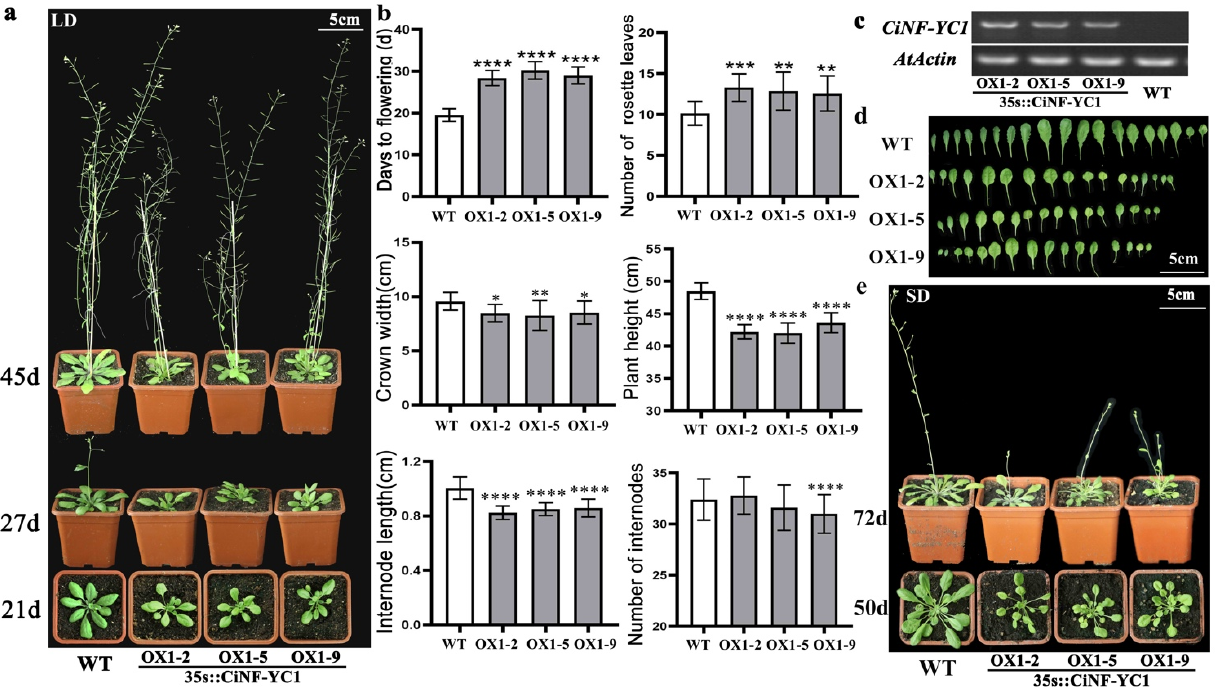
Figure 4. Flowering time and phenotype analysis of CiNF-YC1 overexpressing Arabidopsis . ( a ) Flow- ering time of CiNF-YC1 overexpressing Arabidopsis under LD conditions. ( b ) Phenotype analysis of CiNF-YC1 overexpressing Arabidopsis under LD conditions. Ten independent plants were measured, and error bars indicate standard deviation. * p < 0.05, ** p < 0.01, *** p < 0.001, and **** p < 0.0001 indicate significant differences. ( c ) Identification of CiNF-YC1 overexpressing Arabidopsis by RT-PCR. ( d ) The leaf size of WT plants and CiNF-YC1 overexpressing Arabidopsis . ( e ) Flowering time of CiNF-YC1 overexpressing Arabidopsis under SD conditions.